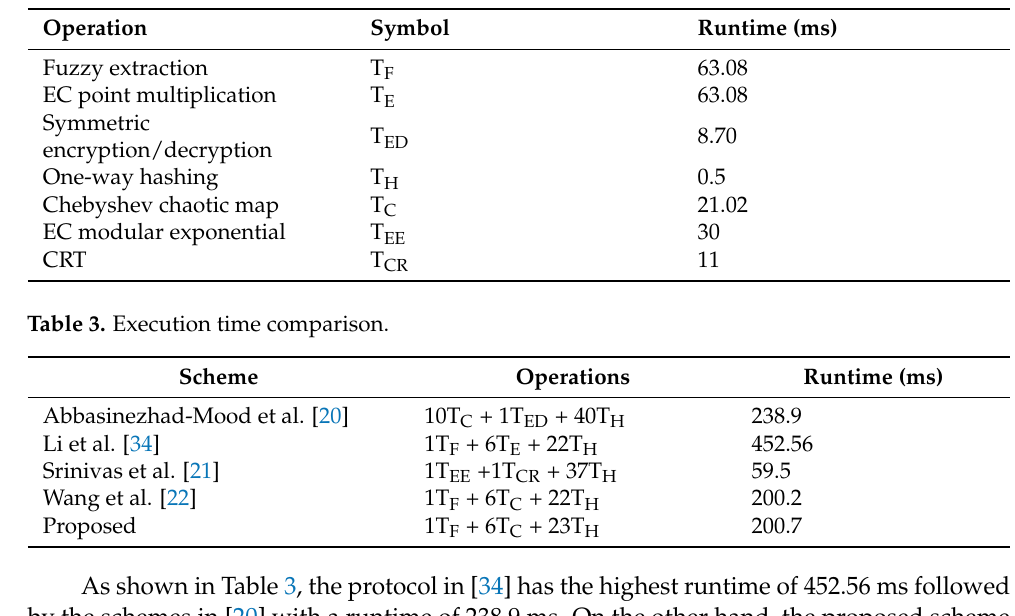
Table 2. Cryptographic runtimes.